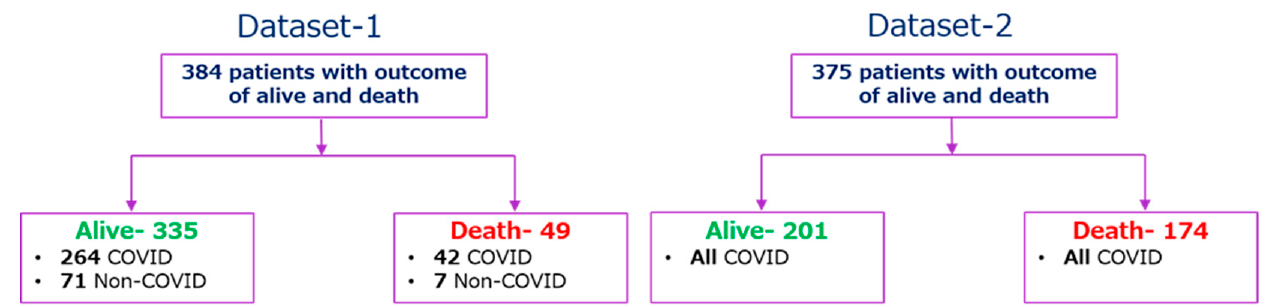
Figure 2. Outcome tree for the patients of Dataset-1 and Dataset-2.